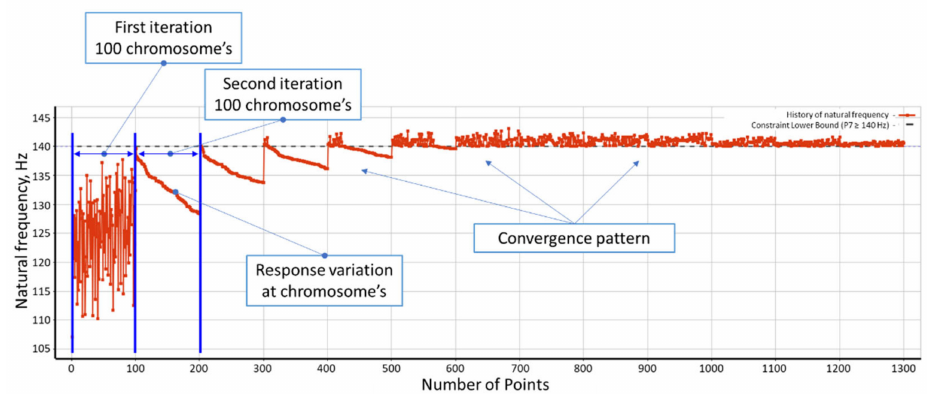
Figure 16. Interpretation of the convergence diagram (history chart).